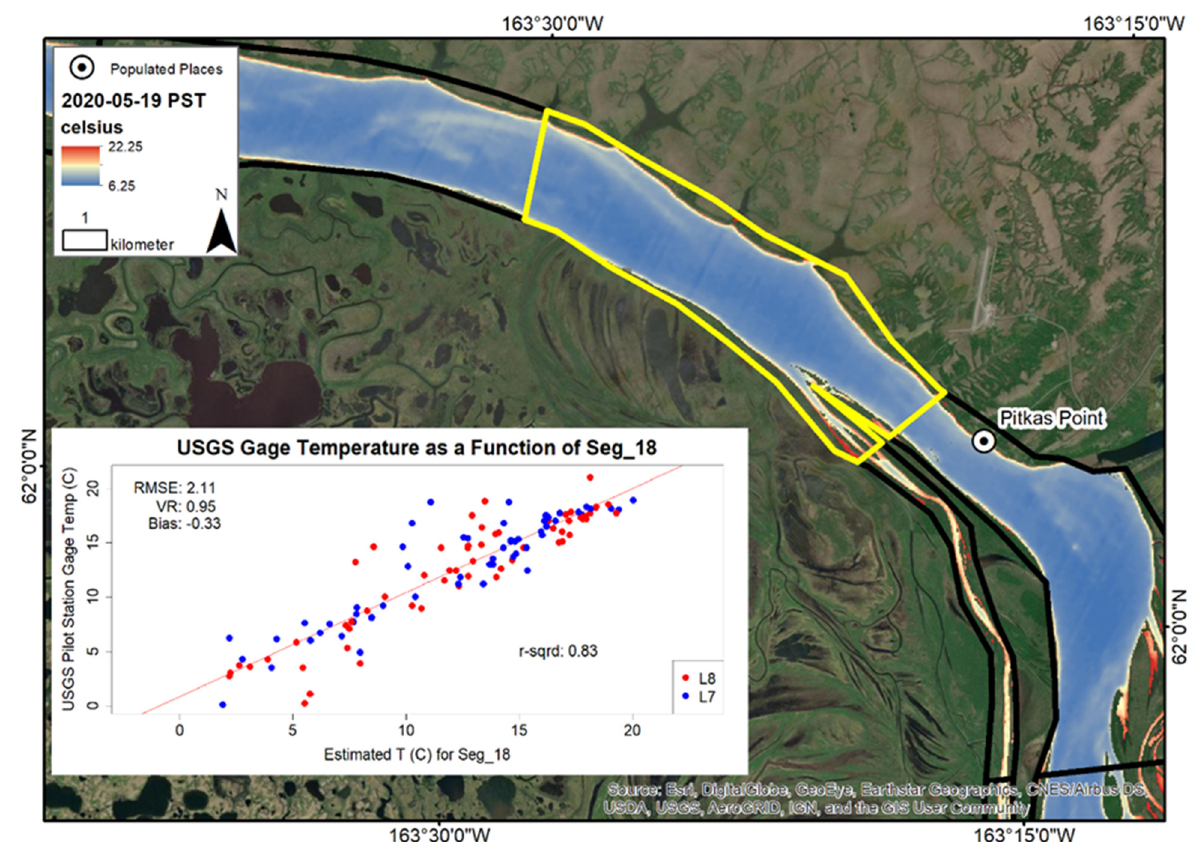
Figure A16. The entirety of the flow of the Yukon becomes constricted to a single channel within Segment 18 after the Driftwood slough. The northern shore of the river abuts the Andreafsky Mountains, while the southern shore comprises lowland sloughs, oxbows, and abandoned river channels. The pST coverage is 100% with no NoData gaps. Correlation with Pilot Station water temperature data is good (RMSE = 2.11 °C, r 2 = 0.83).